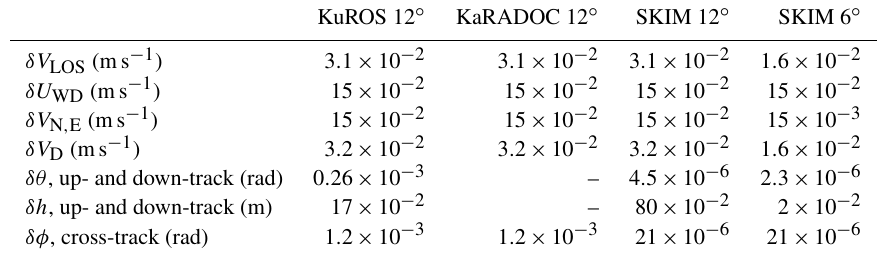
Table 2. Standard deviations of the different error terms in Eq. (19) necessary to achieve a 0 . 40ms − 1 standard deviation for U CD . KuROS 12 ◦